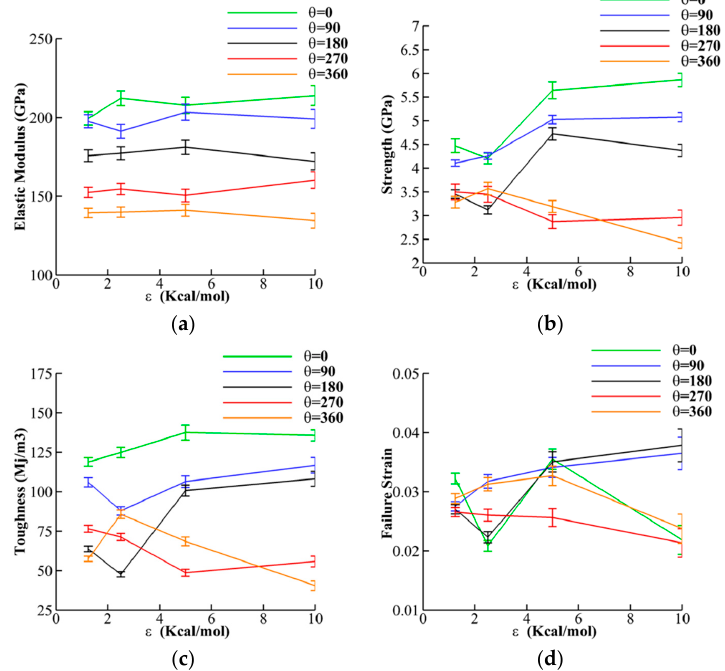
Figure 3. Mechanical performance of 2 × 2 twisted bundles of CNCs for different interfacial interactions. ( a ) elastic modulus, ( b ) strength, ( c ) toughness, and ( d ) failure strain.